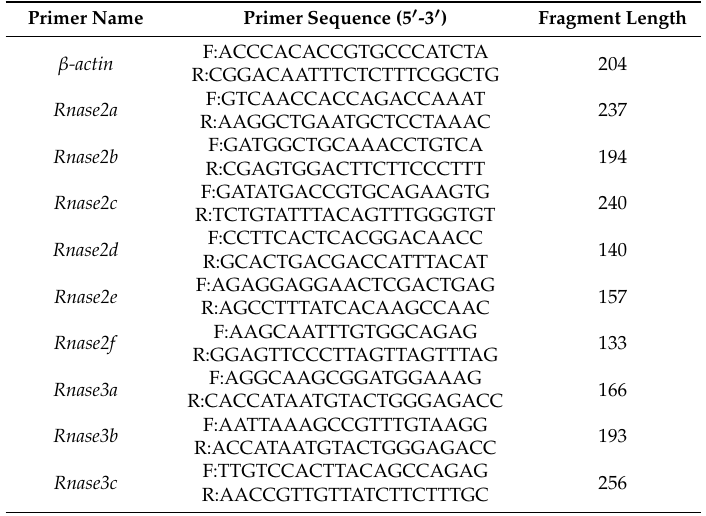
Table 1. Primers for Megalobrama amblycephala Rnase2 and Rnase3 expression